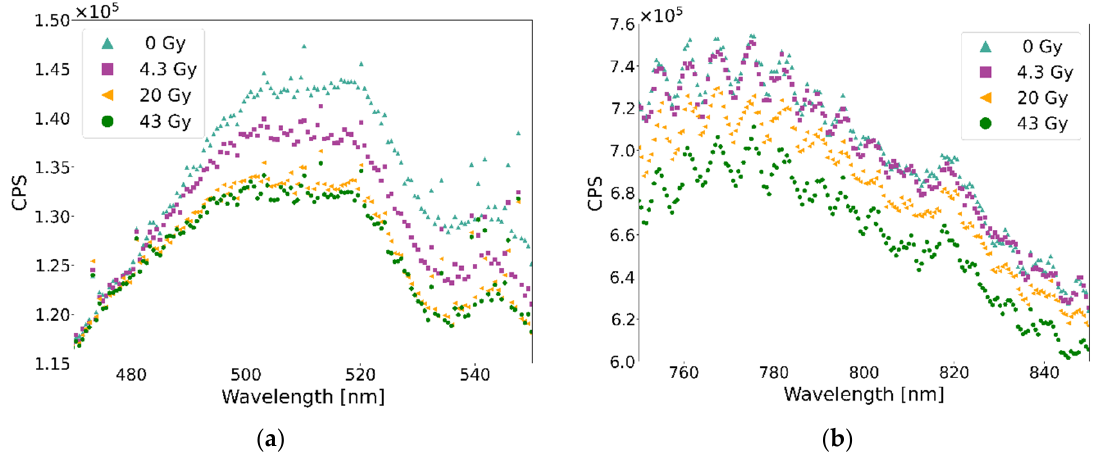
Figure 5. EBT3 gafchromic film reflection spectra in the wavelength range 470–550 nm ( a ) and in the wavelength range of 750–850 nm ( b ). Spectra at different doses have been obtained with a 38 MBq 90 Sr/ 90 Y beta source.